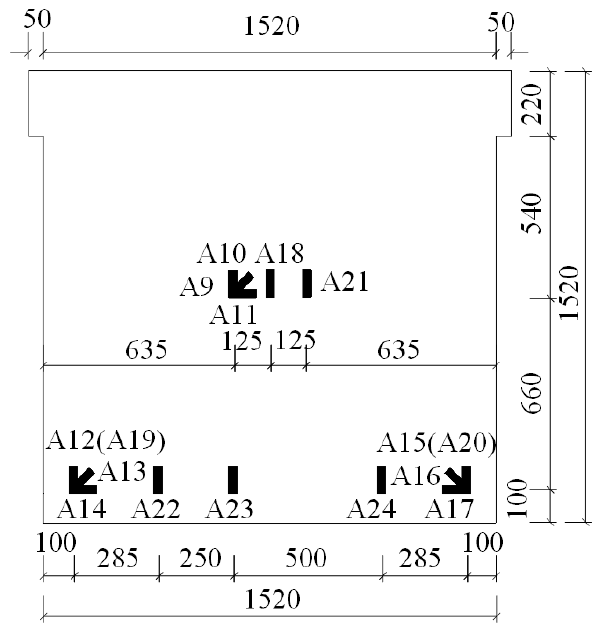
Figure 7. Layout of strain gauges on the concrete and gypsum boards of